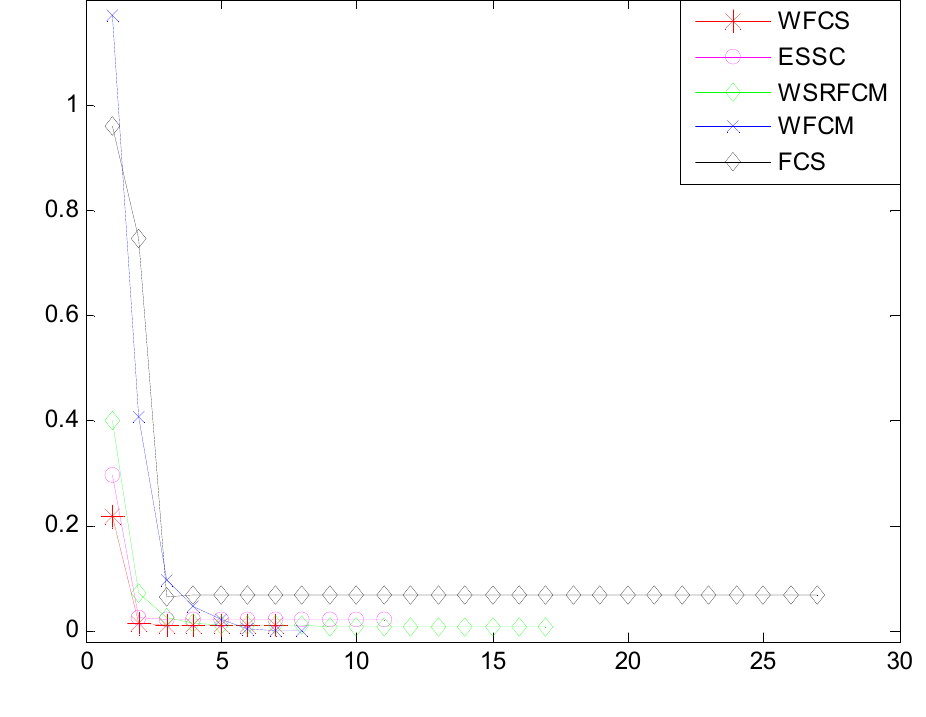
Figure 4. Convergence of the five